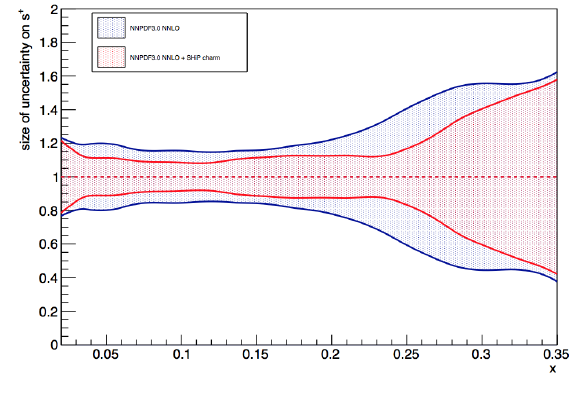
Figure 6. Improvement of the accuracy on s + with SHiP (red) compared to the present status (blue) in the 0 . 02 < x < 0 . 35